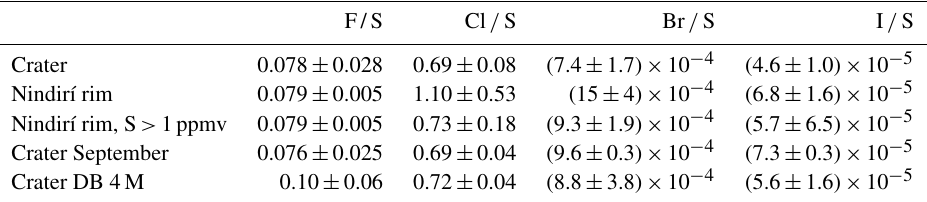
Table 4. Median halogen/sulfur ratios measured at Santiago crater and downwind at Nindirí rim compared with downwind samples from a denser plume S > 1ppmv; the uncertainty is given as the median average